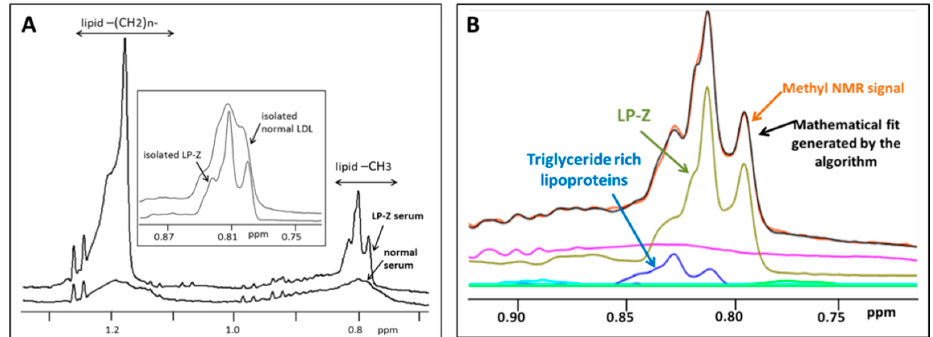
Figure 1. ( A ) Nuclear magnetic resonance (NMR) spectra from a normal serum sample and a serum sample from a subject with liver disease and a high bilirubin concentration “lipoprotein Z (LP-Z) serum”. The high bilirubin sample shows higher signals with differing lineshapes at both the methylene (lipid-CH 2 group at approximately 1.2 ppm) and methyl (lipid-CH 3 group at approximately 0.8 ppm) regions of the NMR spectrum. Inset: expanded view of the methyl group region showing the differences between the broader NMR signal from isolated low-density lipoproteins (LDL) versus the more distinct NMR signal from isolated LP-Z particles. These lineshapes are used as components in the deconvolution models that quantify the lipoprotein particle concentrations. ( B ) An NMR spectrum (orange line) demonstrating the signals from a subject with liver disease and a high bilirubin concentration in the methyl region. The black line shows the mathematically determined signal from the abnormal lipoprotein or LP-Z assay. The fact that these two lines superimpose means that the fit between the mathematically derived signal and the acquired signal is good. The signals from the triglyceride-rich particles are noted in blue; however, based on the lipoprotein analysis there were no signals observed from normal LDL particles in this sample. The signals from the LP-Z particles and serum proteins are represented by the green and purple lines,